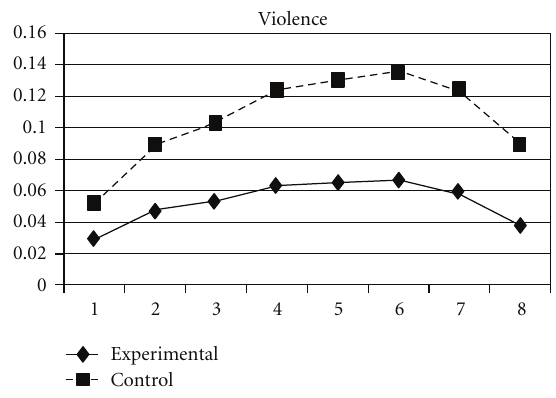
Figure 6: Growth trajectories of the experimental group (all par- ticipants) and control group using substance use scale score as the outcome indicator.